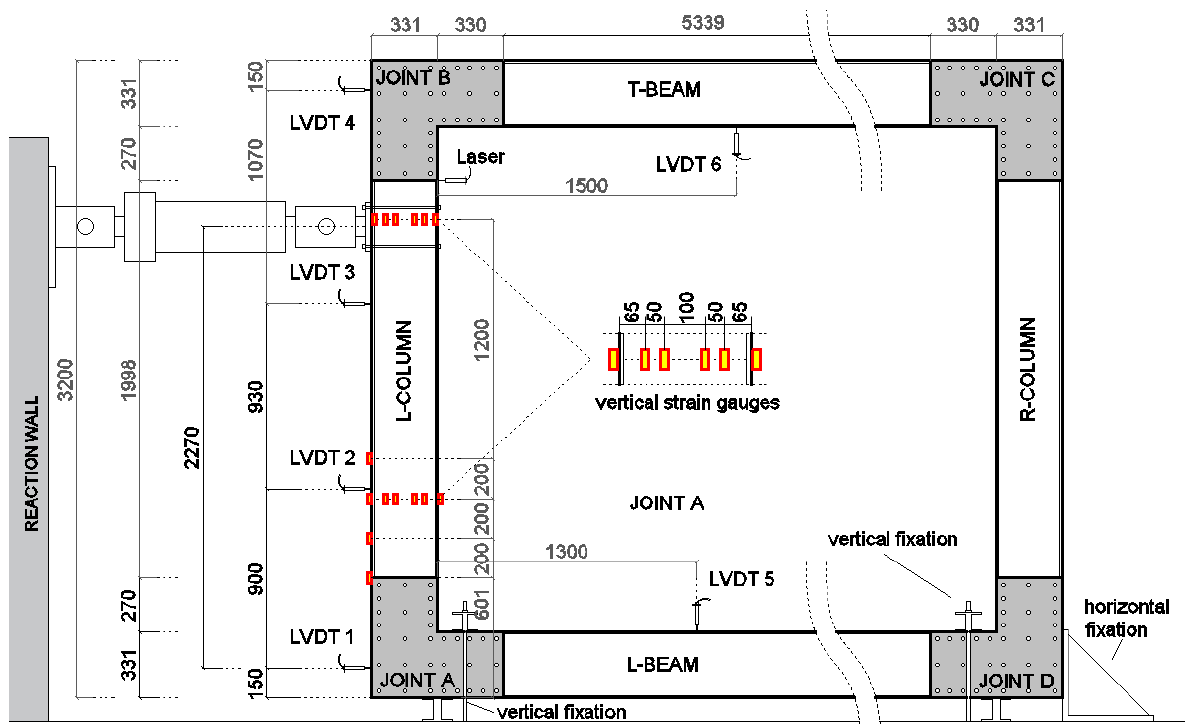
Figure 6. Test set-up of the portal frame, specimen PF (measures in mm). Figure 6. Test set ‐ up of the portal frame, specimen PF (measures in mm) . No connecting elements were placed on the inner side, and the contribution of the transversal frames was neglected. Figure 7 represents a close-up of both the external and the inner sides of the connection system at the intersection between a beam and a column of the portal frame. The frame had a length of 6.6 m and a height of 3.2 m. The frame is simply supported in proximity to the lower joints (joint A and joint D). The vertical displacement of the lower beam in proximity to the joints was prevented by fixation elements, as well as the horizontal displacement in correspondence with joint D. In the service configuration, the lateral displacement of the beam’s out-of-frame plane is prevented by the slabs of the deck. In order to reproduce this condition, wood elements were transversally placed at the mid-span of the lower beam to avoid lateral transversal buckling phenomena. The load was applied at a height equal to 2.27 m with respect to the centre of the lower joints, corresponding to 70% of the column